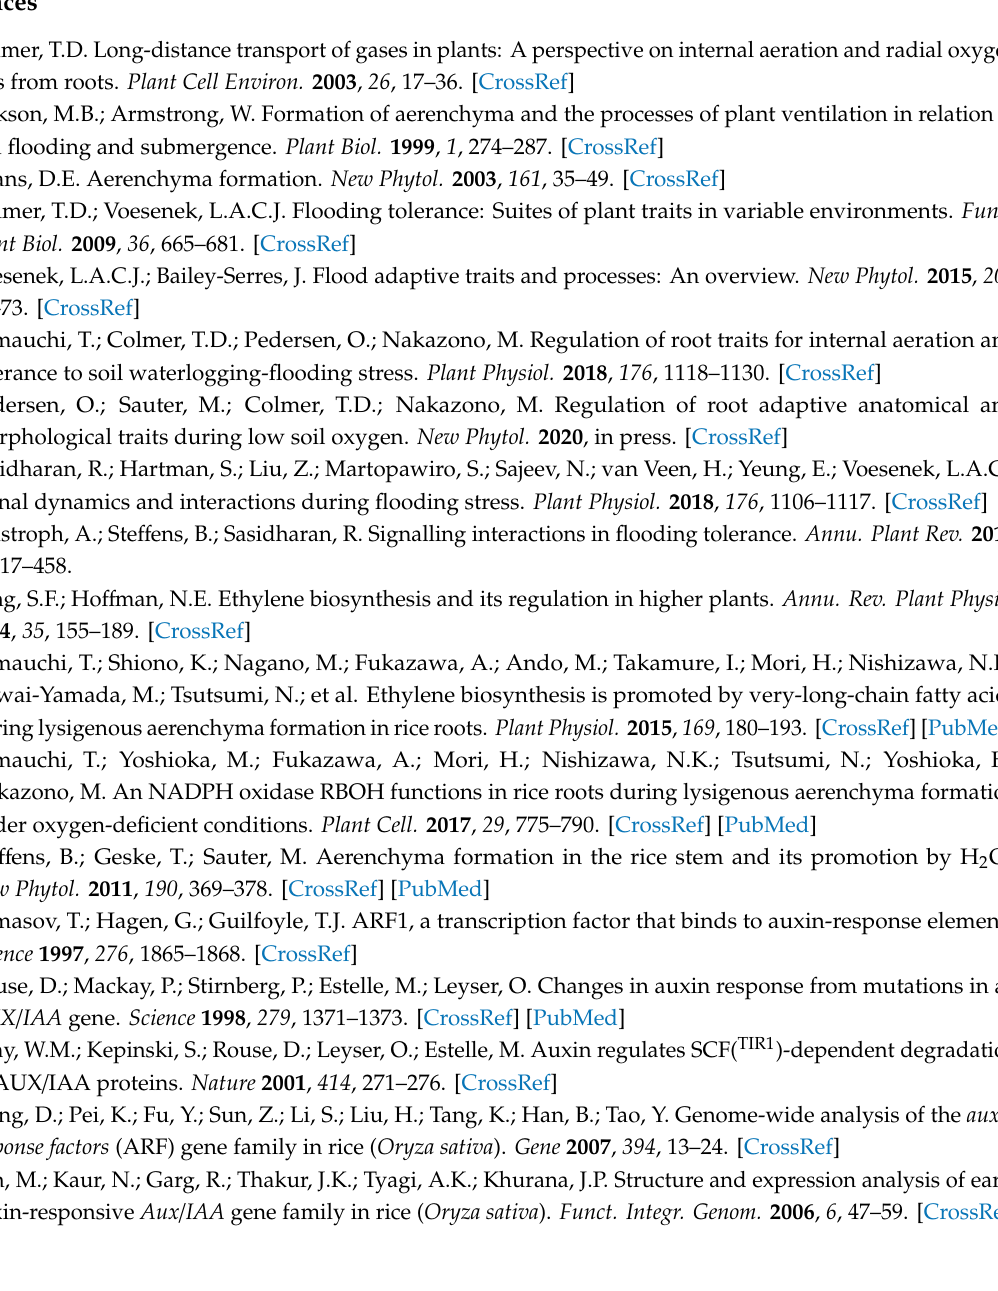
Figure S1: Root elongation under aerated or stagnant conditions with or without the inhibitor treatments; Figure S2: Aerenchyma formation under aerated or stagnant conditions or aerated conditions with or